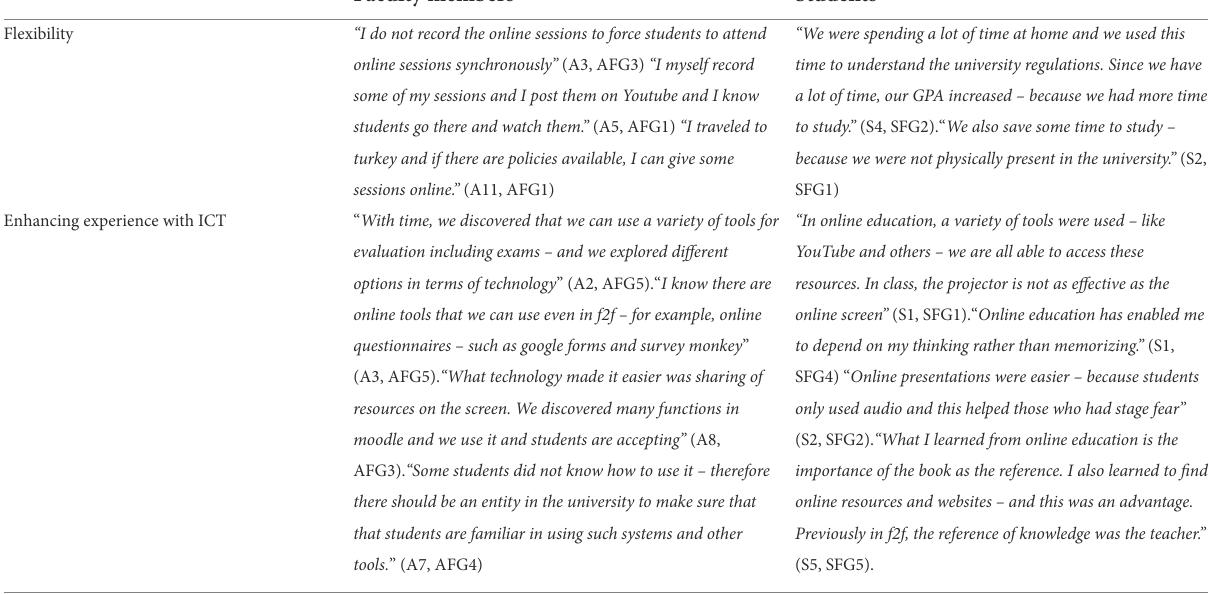
TABLE 7 Performance expectancy.